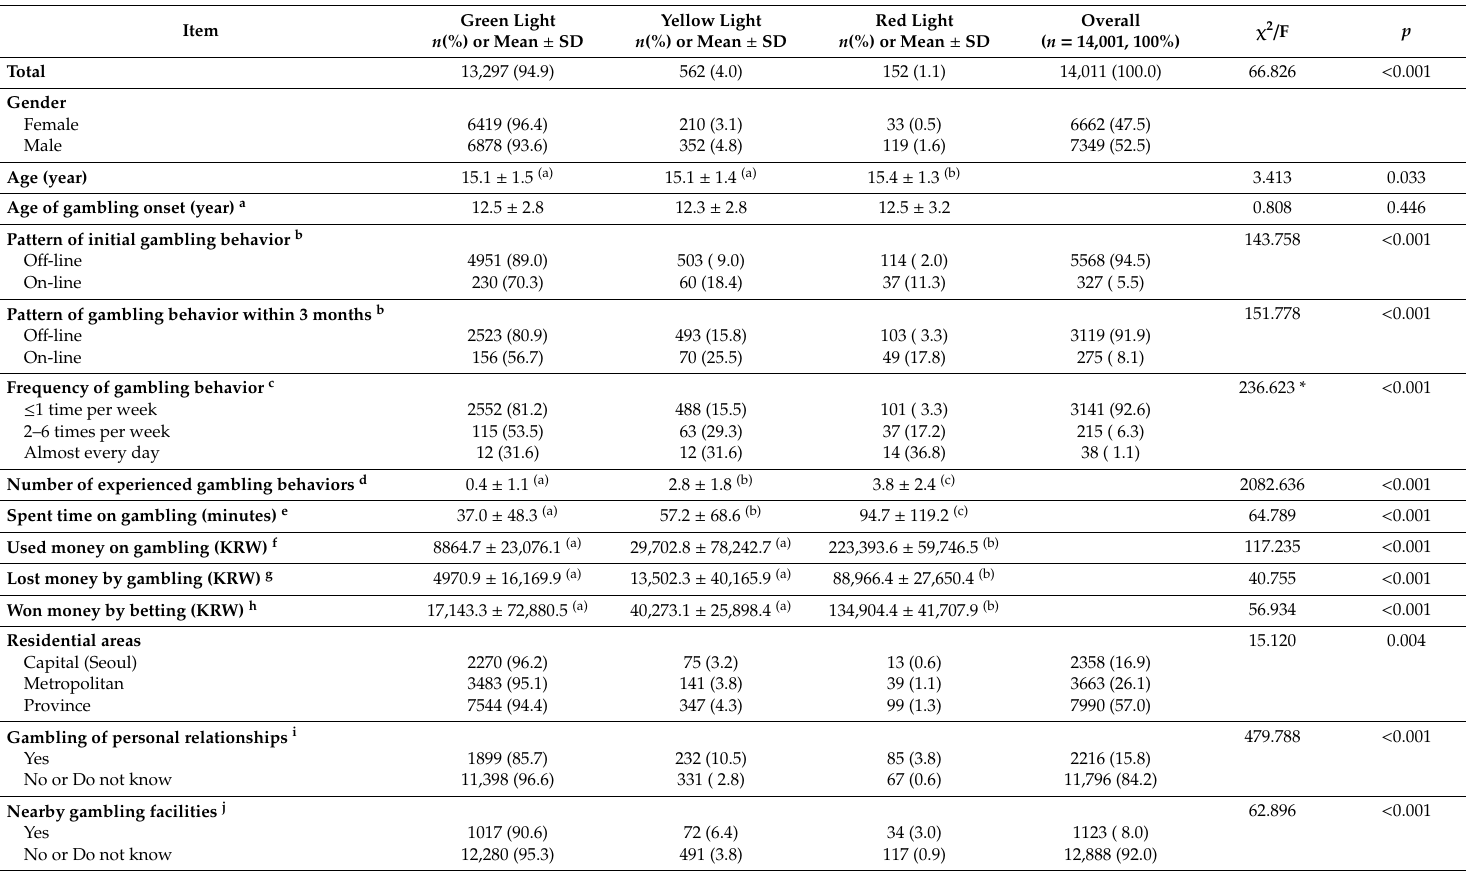
Table 2. Characteristics of gambling according to the level of problem